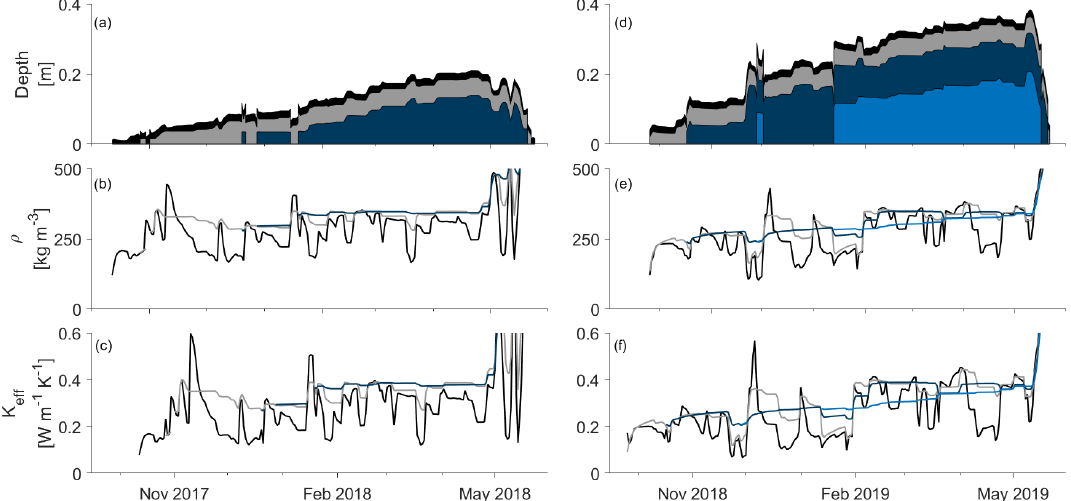
Figure 5. Simulated snow layers and their properties for winter 2017–2018: (a) simulated snow layer thicknesses, (b) snow layer densities and (c) snow layer thermal conductivities. (d–f) As before but for winter 2018–2019. Each colour represents a different computational snow